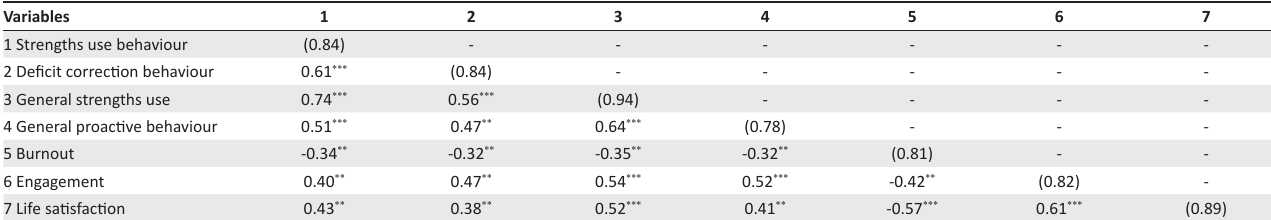
TABLE 4: Cronbach’s alpha coefficients, correlation matrix for the latent variables.